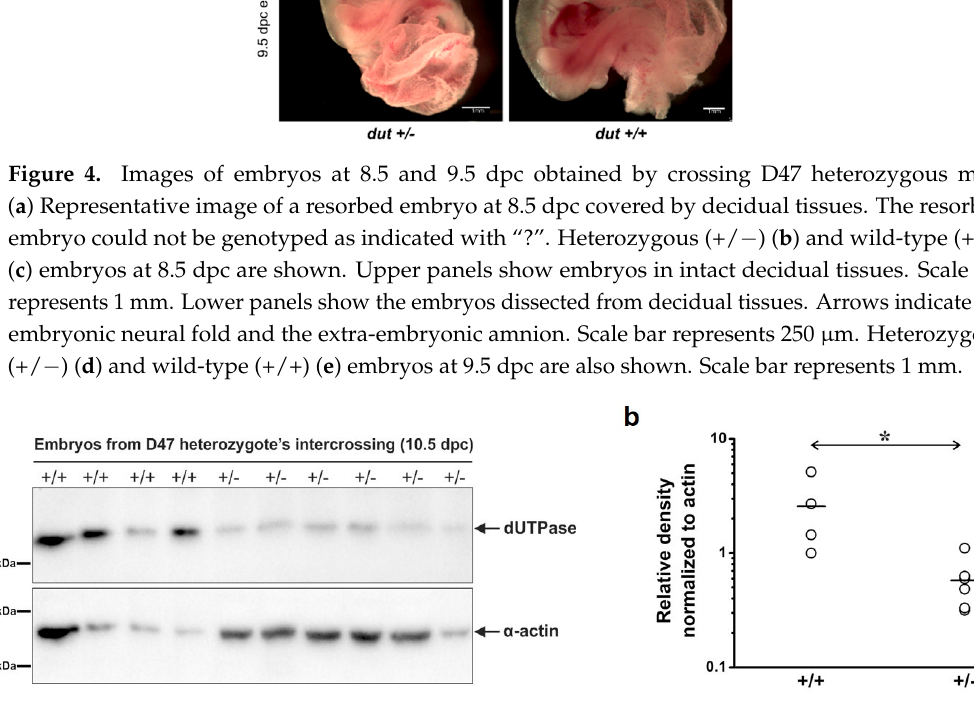
Figure 5. Protein level of dUTPase in embryos at 10.5 dpc from the intercrossing of D47 heterozygous mice. ( a ) Western blot displaying dUTPase protein level in wild-type (+/+) and heterozygous (+/ − ) mice. Membrane was developed against dUTPase (upper part) or α -actin (lower part) as a loading control. Blots are marked with black frame and separated with space. Uncut scans are shown in Figure S8. ( b ) Densitometric data for dUTPase levels from Western blot normalized for α -actin. Mean values are represented with horizontal lines. Every data point is shown, n = 4 for (+/+) and n = 6 for (+/ − ). Statistical analysis was carried out with a two-sided Mann–Whitney U test. * p < 0.05.